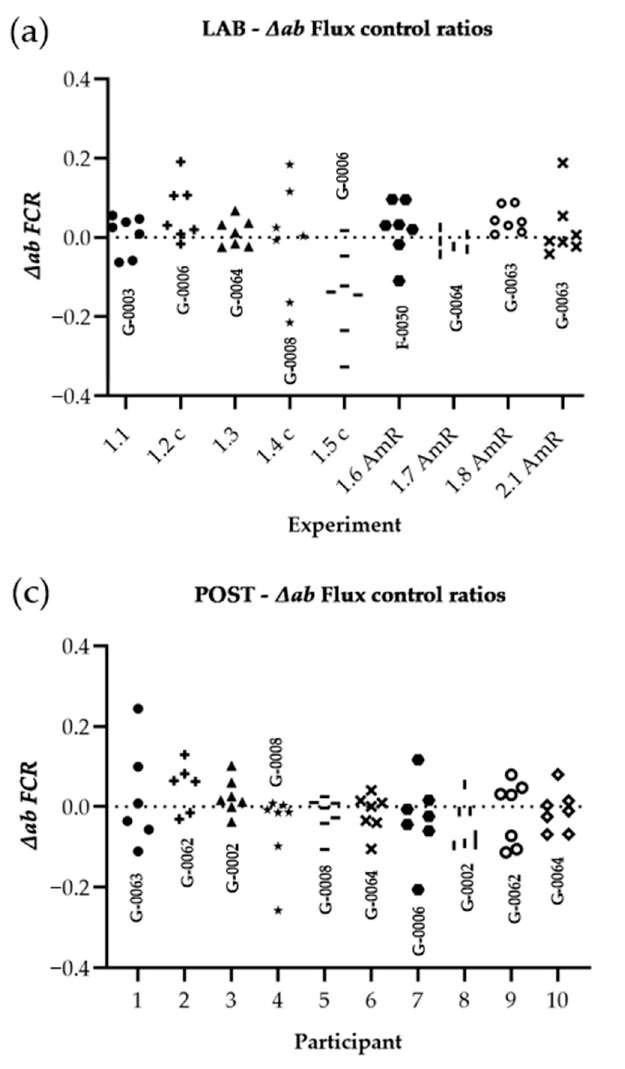
Figure 4. Distribution of variances for J O2 : The difference of both chambers A and B, divided by the respective chamber average [ ∆ ab = (A − B)/AVG(A,B)], calculated from ROX non-corrected data. Graphs show ∆ ab from experiments per- formed in the laboratory of Oroboros Instruments ( a ) in field conditions before the ultramarathon race ( b ), right after ( c ) and 24 h after the finish ( d ). ∆ ab for J O2 of all experiments (LAB, PRE, POST, REC) are shown in ( e ). ∆ ab for J O2 are plotted against average chamber J O2 [pmol/s/mL] to evaluate the dependence of ∆ ab on J O2 ( f ). The linear trend line and a 95% confidence interval are shown. See Table A1 in the appendix for O2k background correction values and Table A2 for O 2 calibration of each